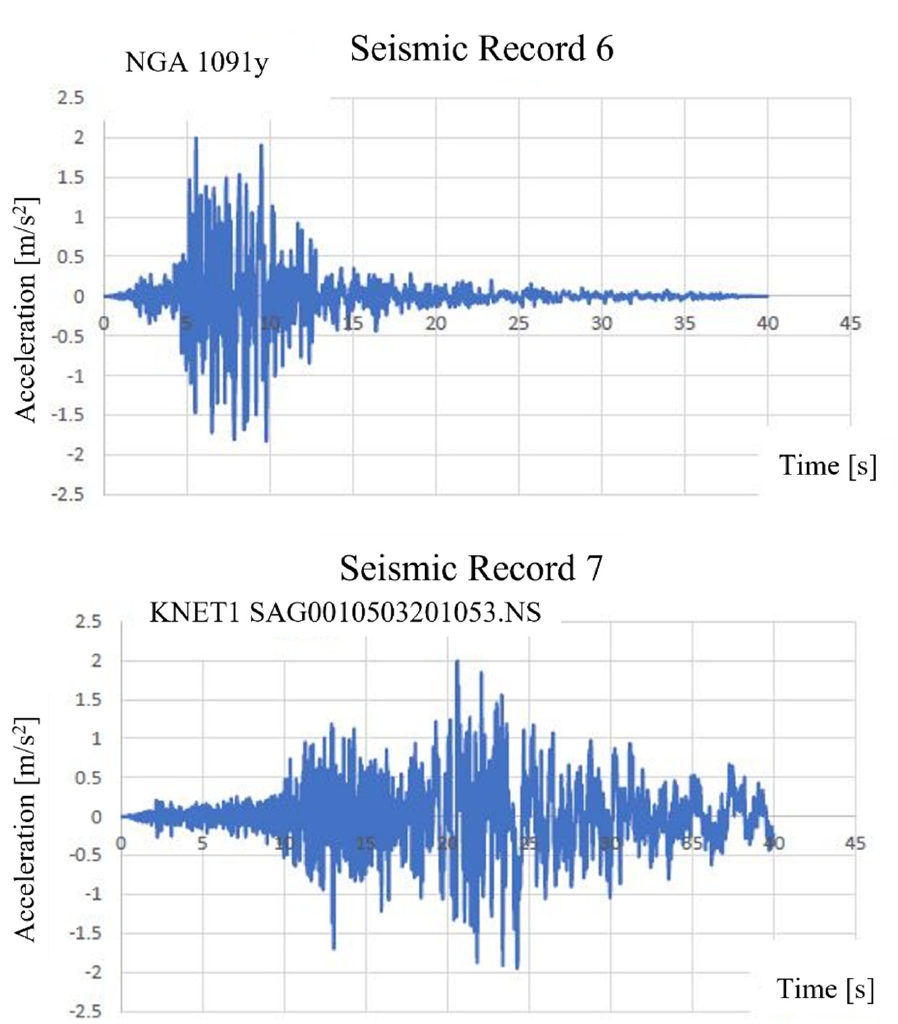
Figure 16. Seismic records.